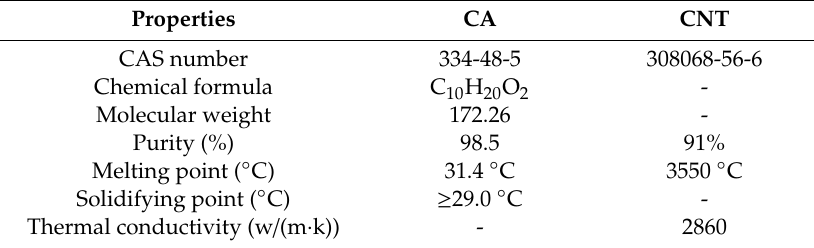
Table 2. Main properties of capric acid (CA) and carbon nanotubes